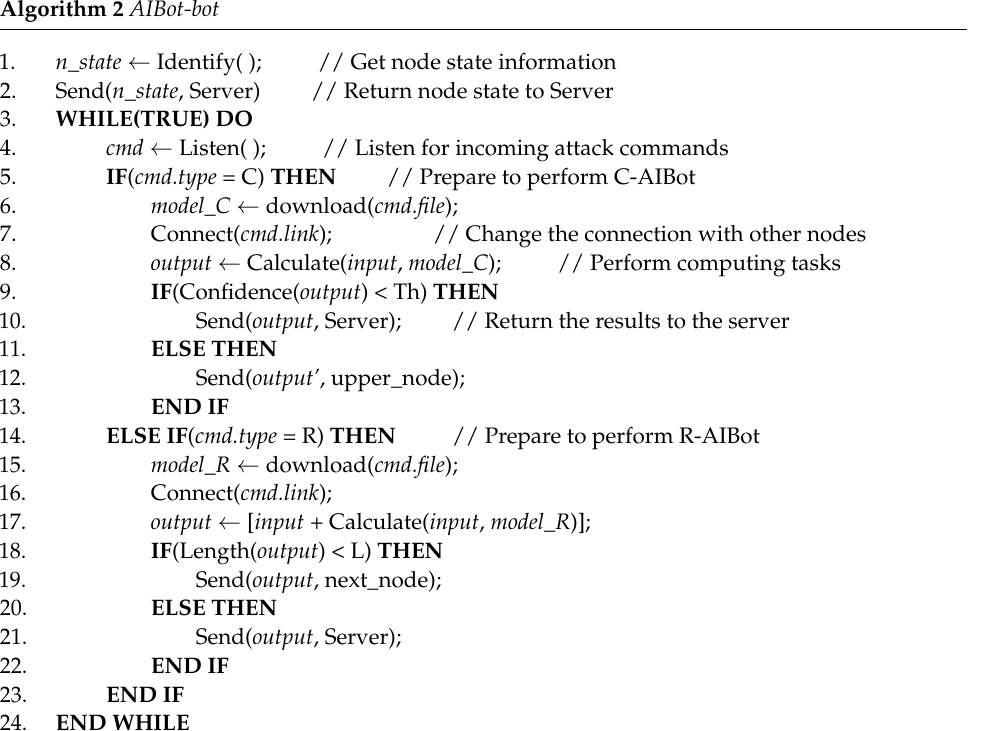
Figure 8. Task execution process.